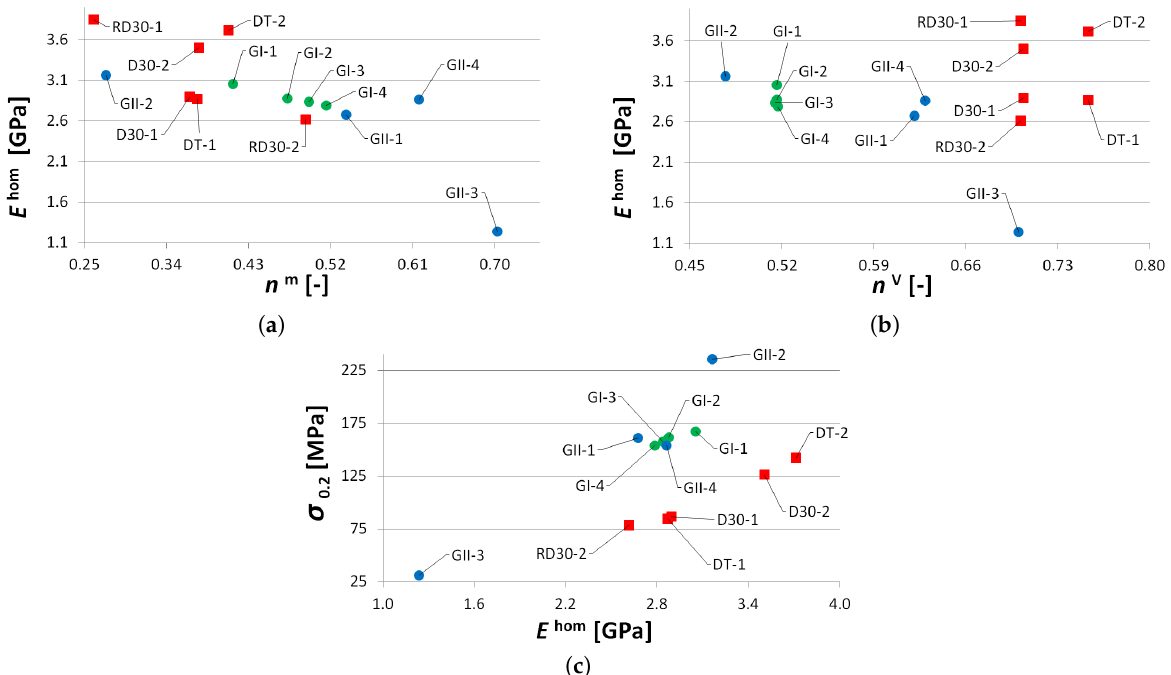
Figure 13. Comparing mechanical properties of trabecular and gyroid structures: ( a ) Young’s modulus vs. actual porosity n m , ( b ) Young’s modulus vs. theoretical porosity n V , ( c ) yield strength in compression vs. Young’s modulus.